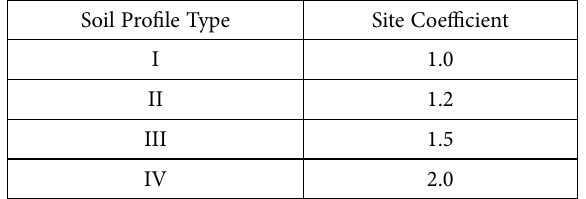
Table 2. Site coefficient (S) (FHWA 1995)